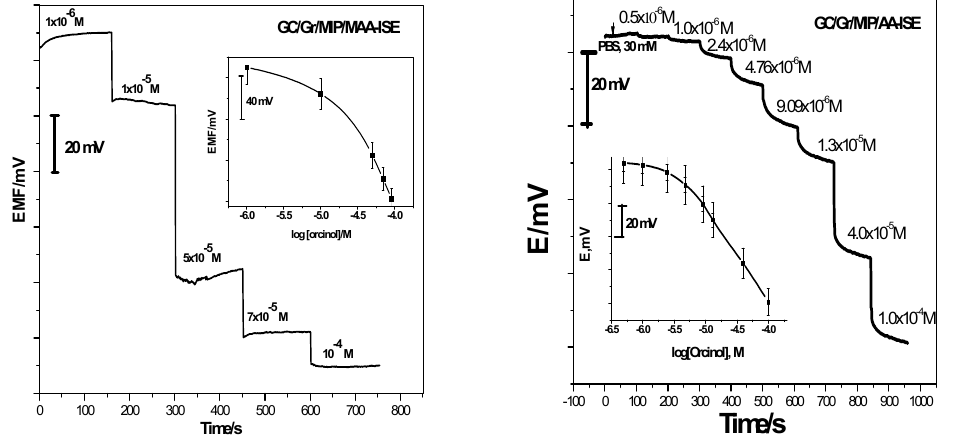
Figure 5. Time trace of GC / Gr / orcinol-ISE in the orcinol concentration range of 10 − 6 –10 − 4 M. The inset shows the calibration curve of the proposed sensor.